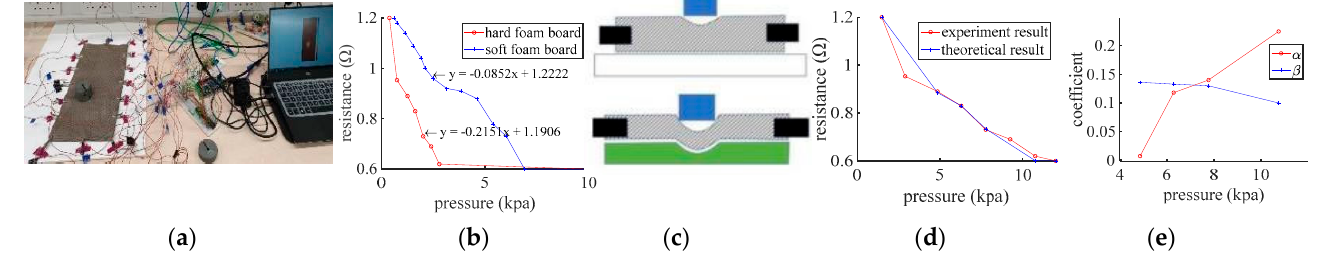
Figure 1. ( a ) The overview of the system (top: weights, middle: spacer fabric; bottom: substrate; right: laptop); ( b ) Experi- ment 1 results; ( c ) the side view of the different pressing deformations (white rectangle: hard foam board, green rectangle: soft foam board); ( d ) Experiment 2 results; ( e ) α , β during pressing